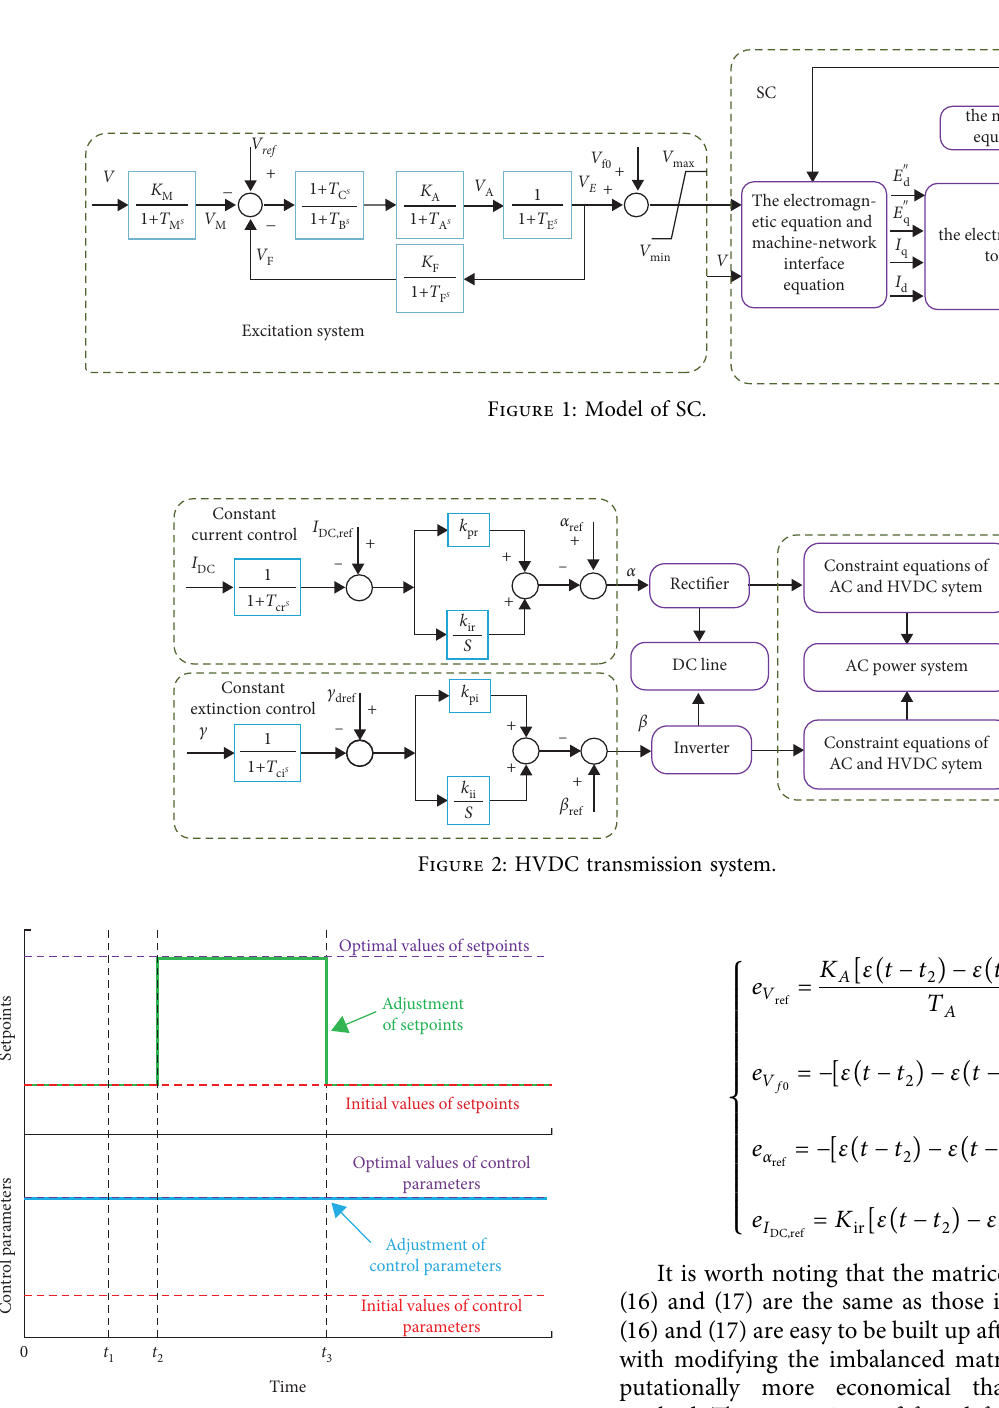
Figure 3: Adjustment of control parameters and set-points with diferent